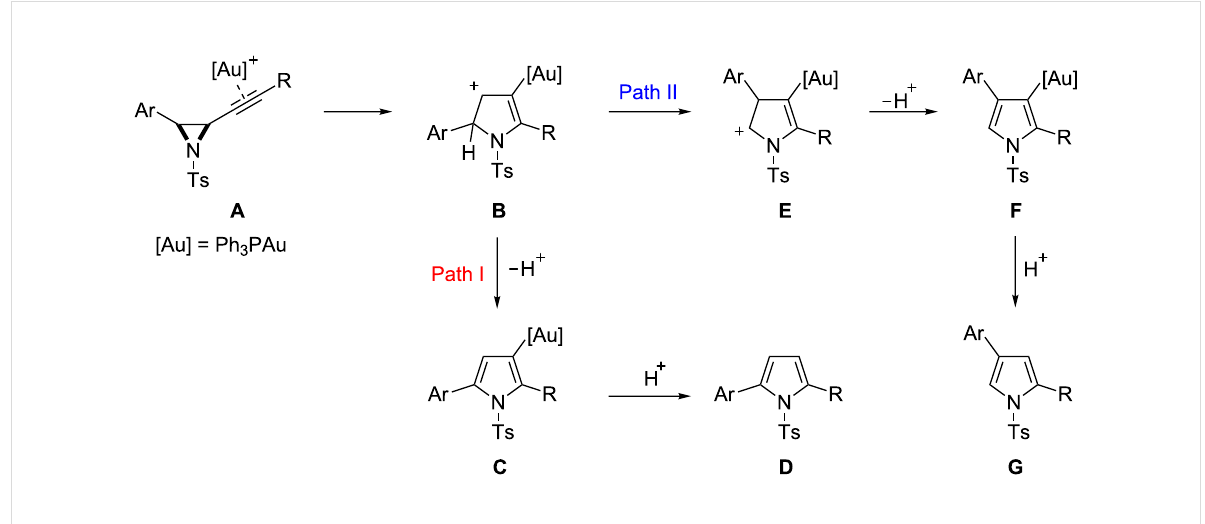
Scheme 2: Working mechanism to rationalise the formation of two regiosomeric pyrroles in the gold catalysed cycloisomerisation of alkynyl aziridines.